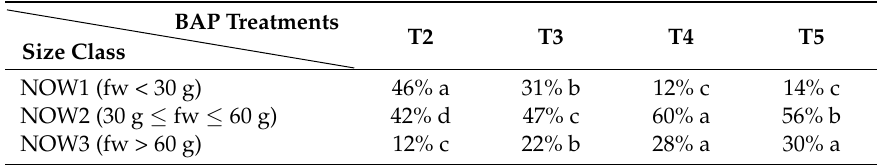
Percentage distribution of the nursery offshoot weight (NOW) classes according to 6-benzylamino purine (BAP)